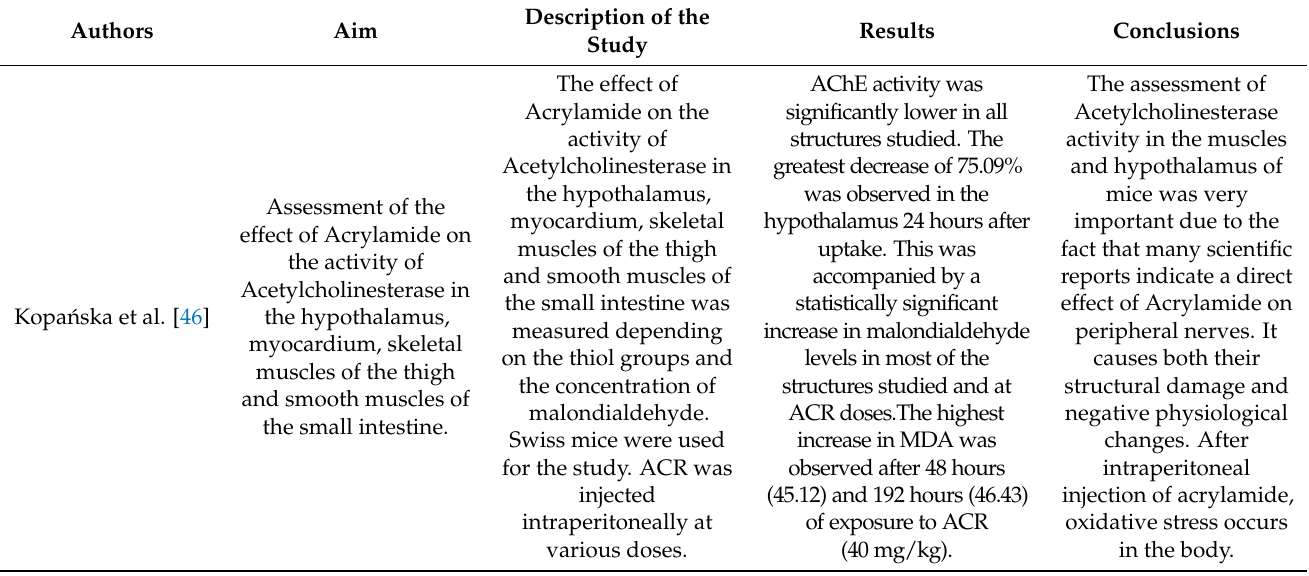
Table 3. Effect of Acrylamide on